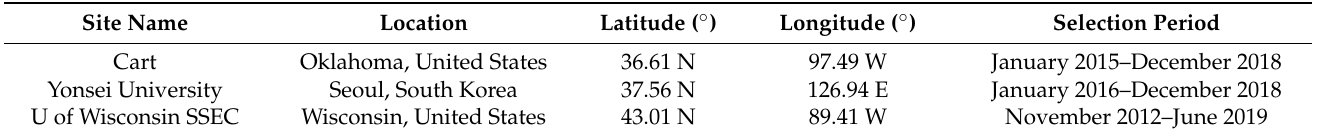
Table 3. The information of AERONET sites, which includes the site name, location, longitude, latitude, and data selection